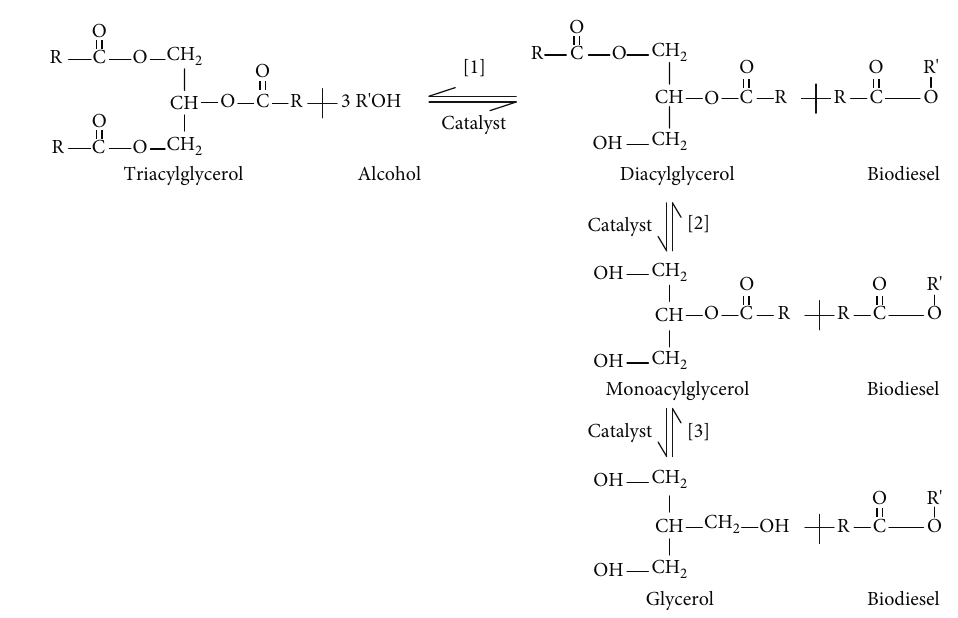
Figure 1: Biodiesel production by transesteri fi cation reaction [69].